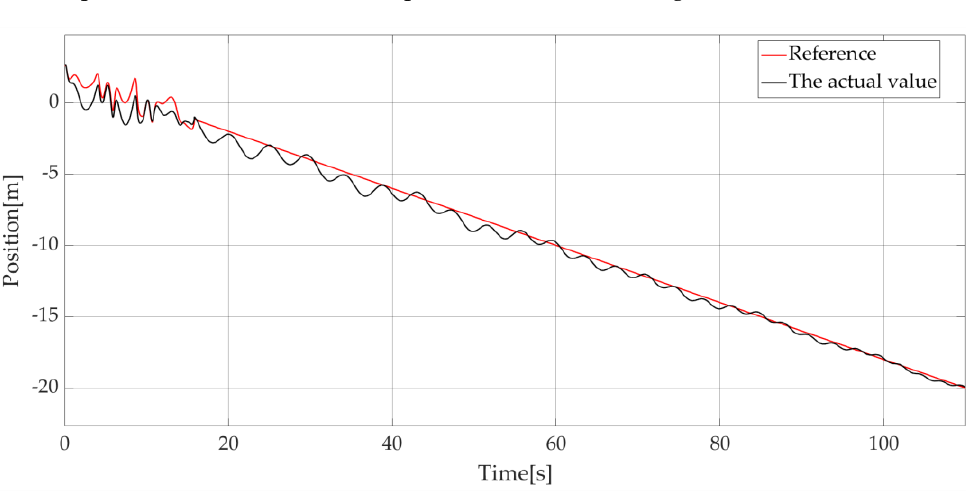
Figure 19. L = 5 m, V = 0.2 m/s, Heave errors with and without compensation.